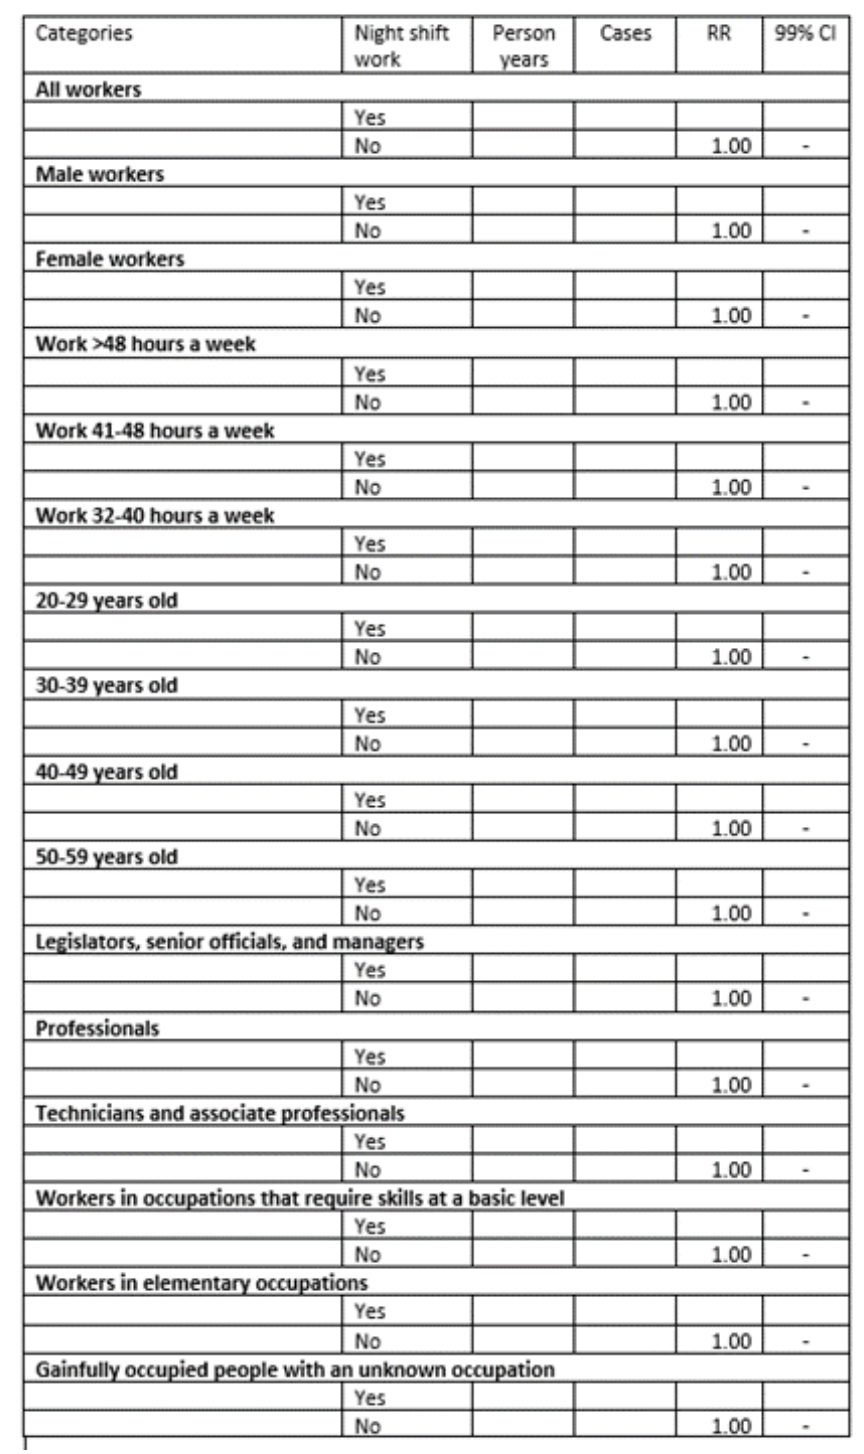
Figure 3. Dummy table: rate ratios (RRs) with 99% CIs for incident use of psychotropic drugs as a function of night work among employees in Denmark